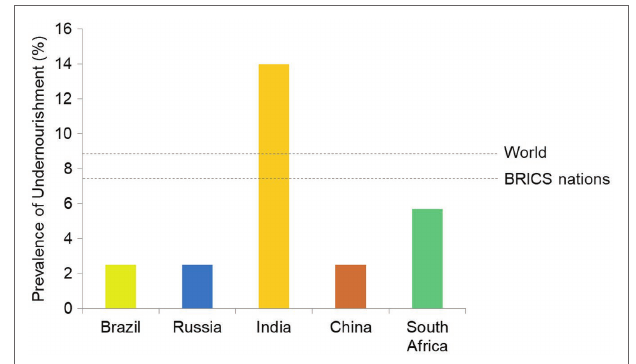
FIGURE 3 | Prevalence of undernourishment (PoU) in BRICS